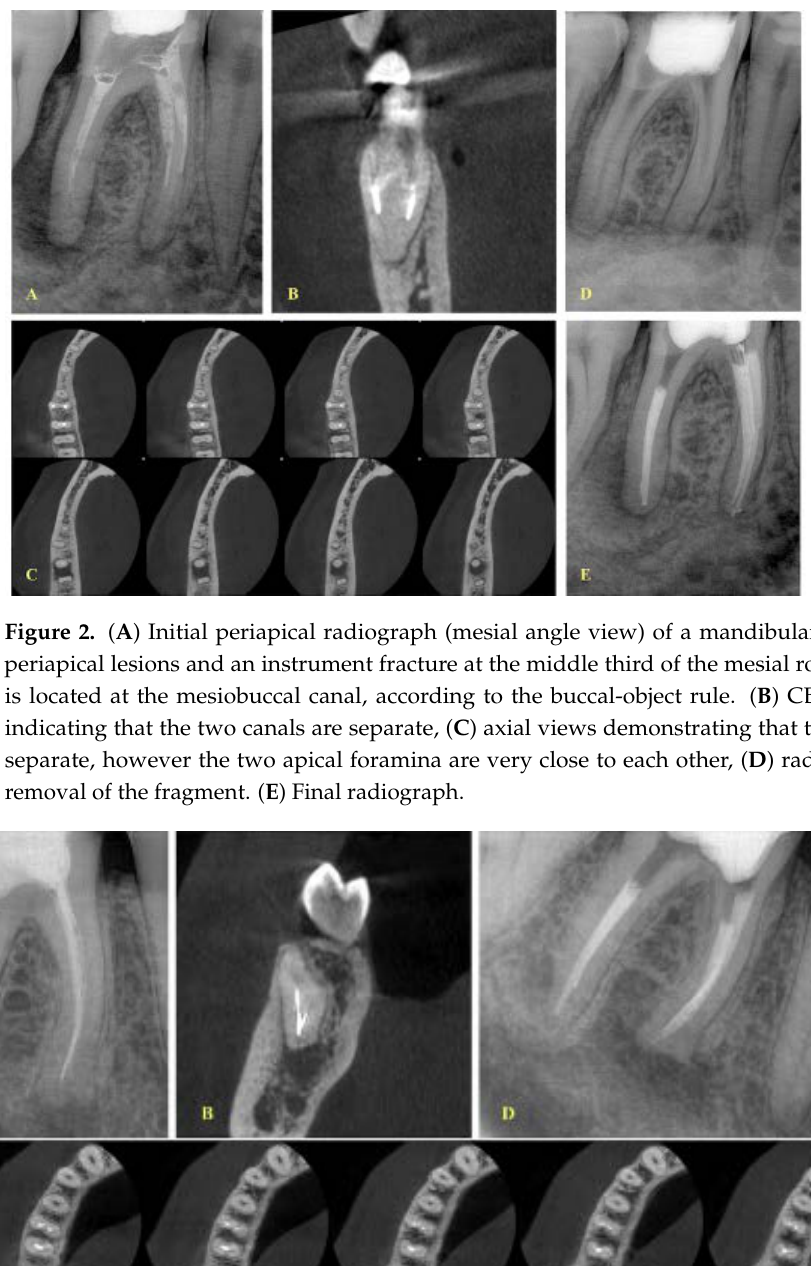
Figure 4. ( A ) Initial radiograph of a maxillary first molar with periapical lesions and an instrument fracture at the middle-apical third of the mesial root, ( B ) A second initial radiograph (mesial view) of the case, C. Coronal view demonstrating that the fragment is located at the mesiobuccal 1 canal (MB1) and the two canals are merging at the apical third, ( D – F ) Consecutive axial views demon- strating that the two canals have a common apical foramen, ( G ) Final radiograph with the fragment